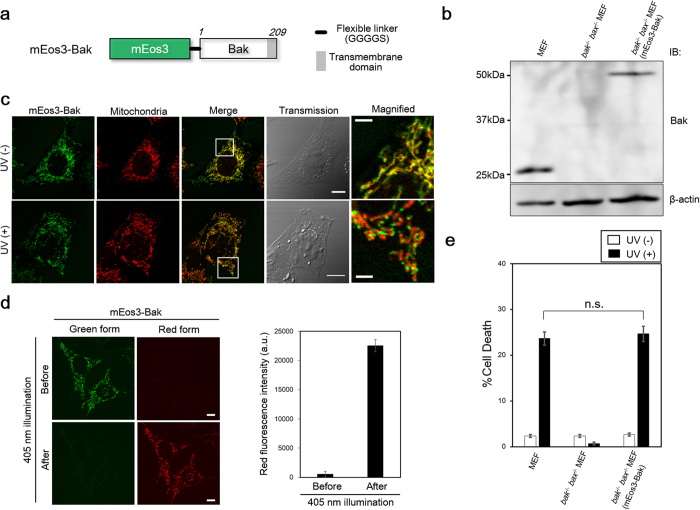
Generation of a cell line expressing mEos3-Bak.(a) Schematic construct of mEos3-Bak. mEos3 is fused to Bak at the N-terminus with a flexible linker (Gly, Gly, Gly, Gly and Ser). Numbers in italics show the residue of amino acids in Bak. Transmembrane region for mitochondrial localization is shown as a gray box (189–209). (b) Western blot analysis for investigating the expression of mEos3-Bak in the cell line. The bands indicate the expression of mEos3-labeled Bak (49.6 kDa), endogenous Bak (23.3 kDa) and β-actin, respectively. (c) Confocal imaging of the cells in the presence or absence of UV irradiation. Mitochondria were visualized by MitoTracker CMXRos dye. Magnified images in white boxes (Merge) are shown (right panels). Scale bars: 10 μm (transmission) or 2 μm (magnified). (d) Violet-light-dependent photo-conversion of mEos3-Bak. UV (254 nm) light was irradiated and subsequently fluorescence intensity in red form of mEos3 before and after violet light illumination was measured (right). Scale bars: 10 μm. Data are represented as mean ± s.e.m. (n = 3 cells). (e) Trypan blue exclusion assays for examining cell viability upon UV stimulation. Statistical analysis was performed with two-tailed unpaired Student’s t-test. In the analysis, P > 0.05 is indicated as not significant (n.s.). Data are represented as mean ± s.e.m. (n = 3).